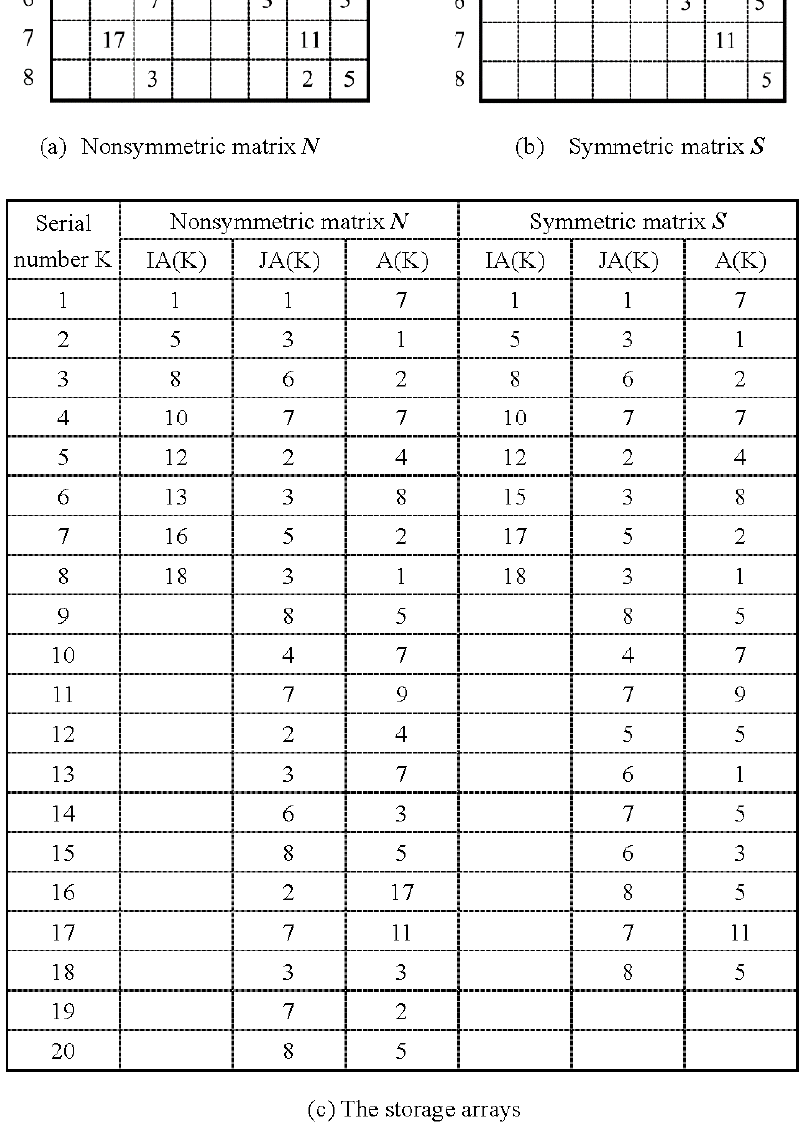
Figure 4. Storage method of CSR.